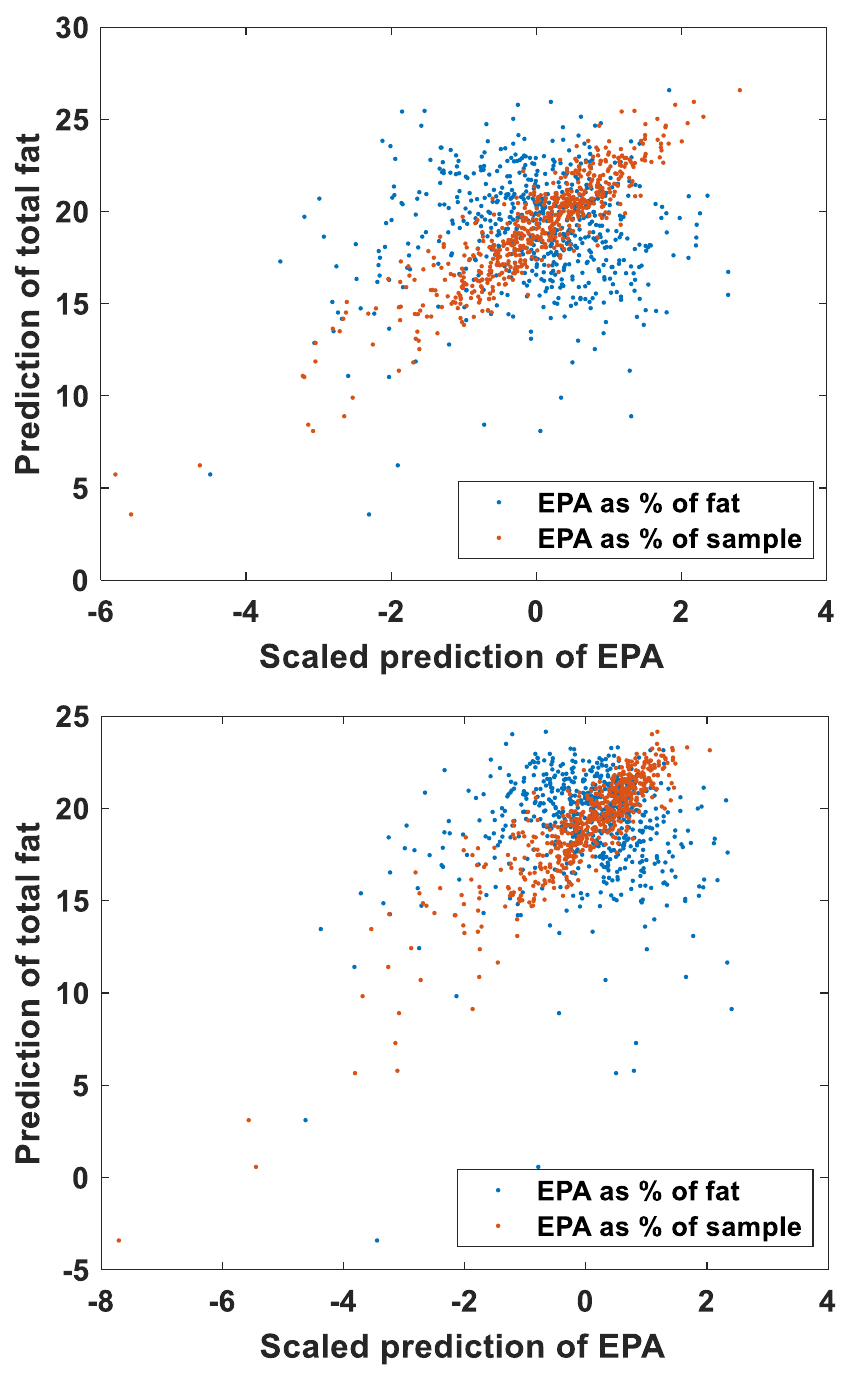
Figure 5. The covariance of EPA and fat predictions shown for NIR ( upper plot ) and Raman spec- troscopy ( lower plot ) for EPA as percentage of fat and for EPA as percentage of sample.